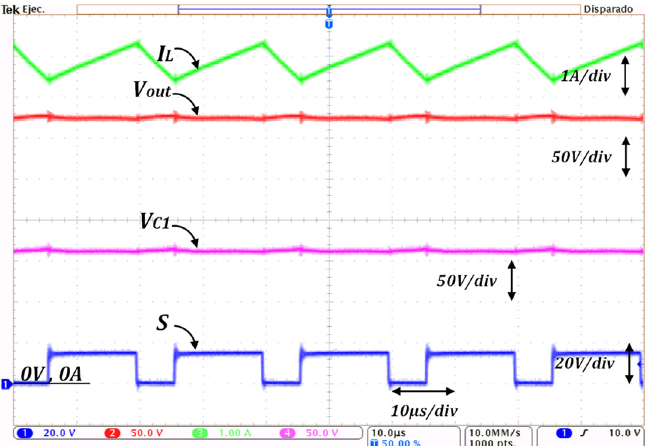
Figure 35. Important waveforms of the converter operation, from top to bottom: the current through the inductor, the output voltage, the voltage across capacitor C 1 , and switch voltage for D = 0.7.